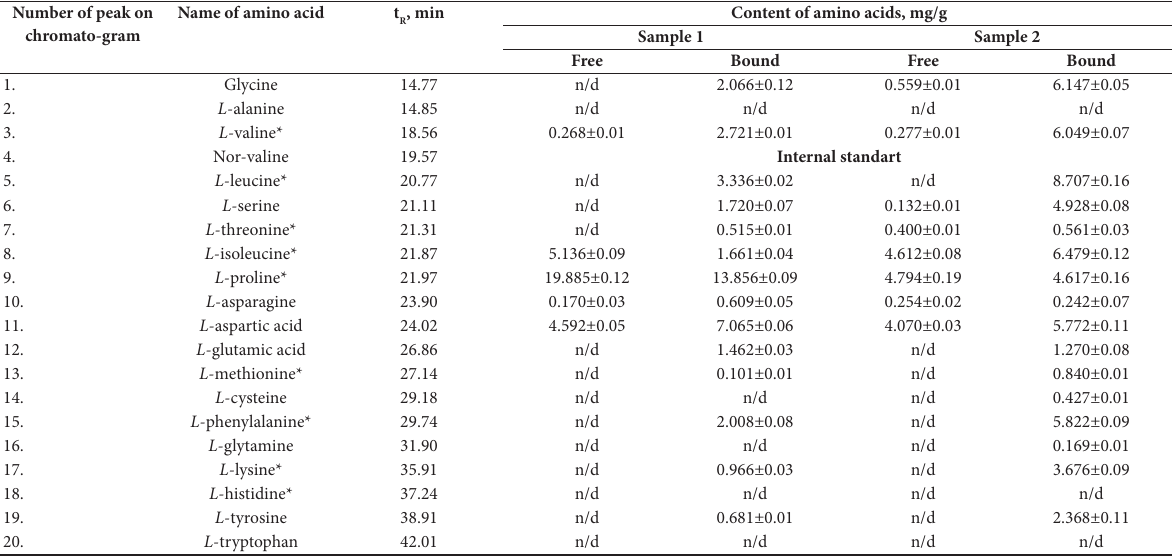
Table 3. Content of amino acid composition in the samples of the plant mixtures. Number of peak on chromato-gram